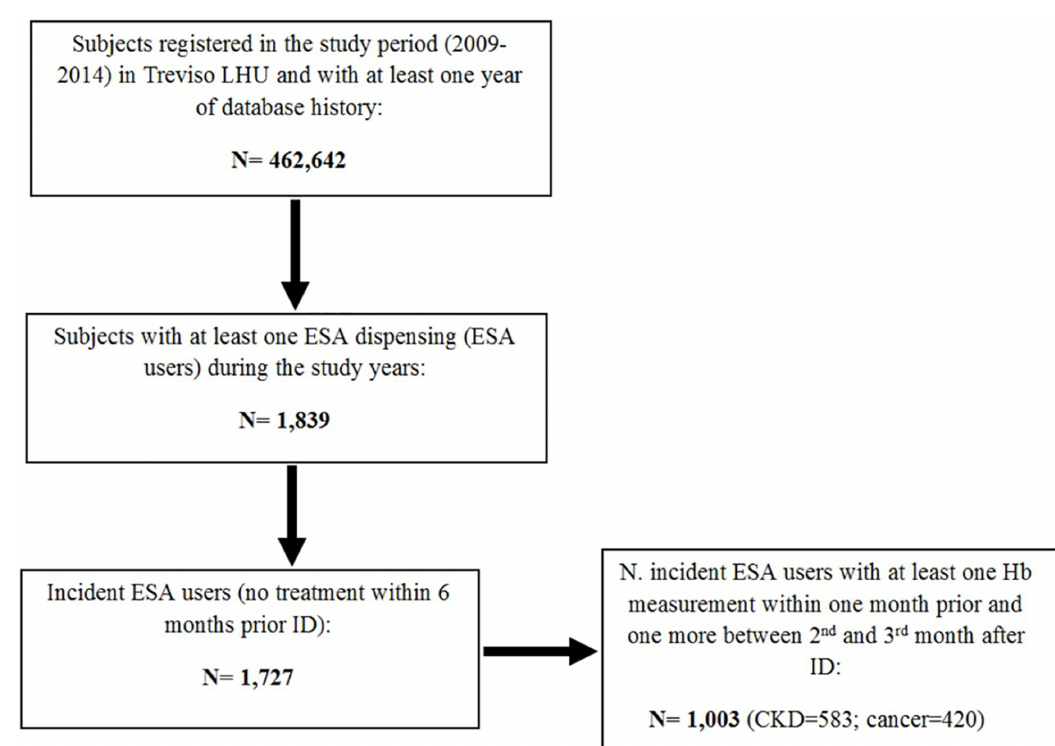
Fig 2. Inclusion in the study of incident ESA users from Treviso LHU. Index Date (ID) = date of ESA treatment start; LHU = Local Health Unit; ESA = Erythropoiesis-stimulating agents; Hb = Hemoglobin; CKD = Chronic Kidney Disease.